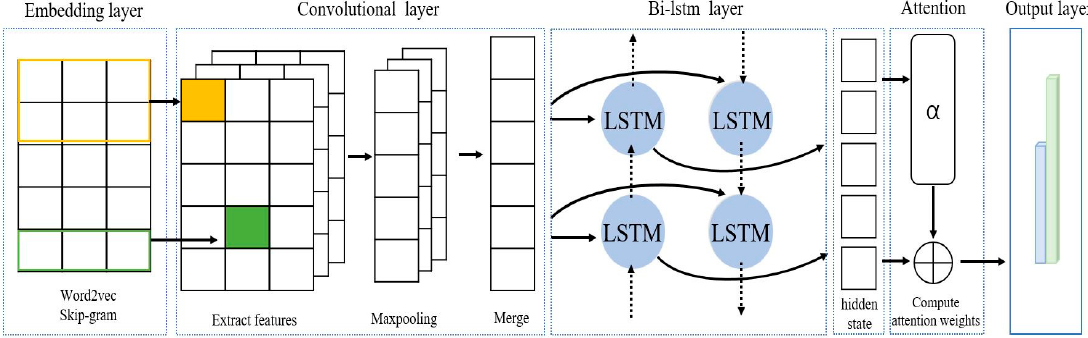
Figure 4. The proposed model architecture.